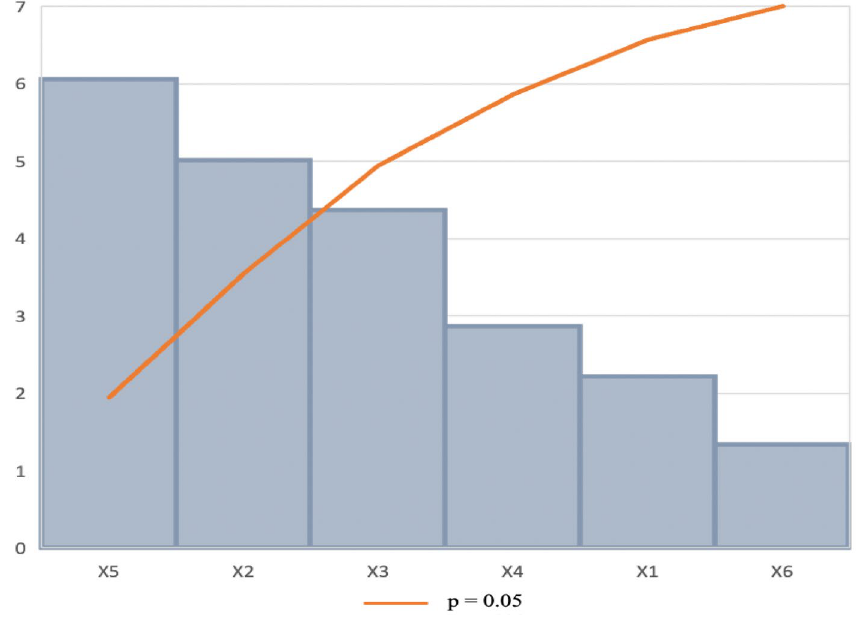
Figure 1. Pareto chart of standardized effects for the production of xylanase. Incubation temperature (X 1 ), incubation time (X